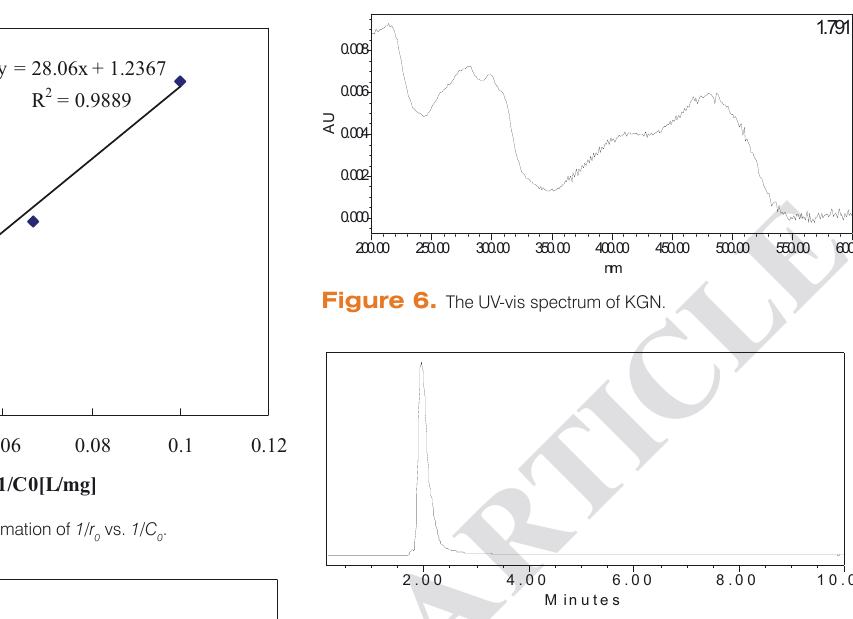
Figure 7. Chromatography spectrum of KGN after 2 h of irradiation with